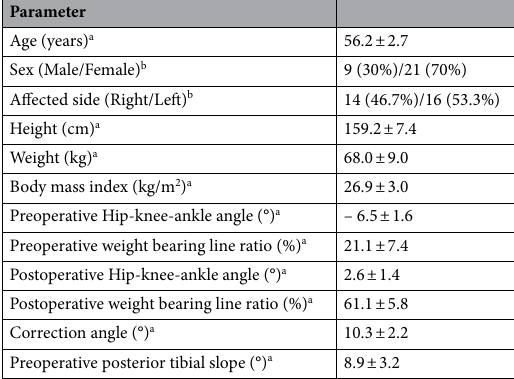
Table 1. Demographic data of patients. a The values are presented as mean ± standard deviation. b The values are presented as n